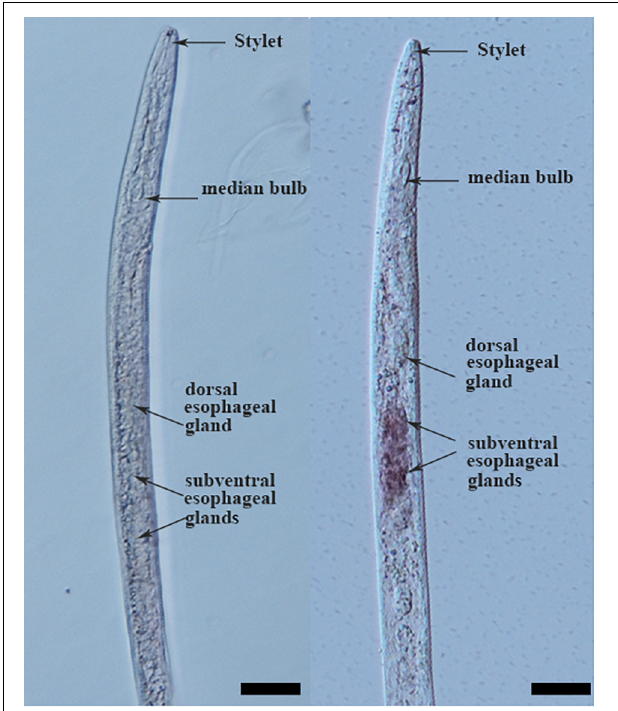
FIGURE 2 | Subventral gland localization of Mg-PEL1 in the pre-parasitic second stage juveniles of Meloidogyne graminicola . Fixed nematodes were hybridized with digoxigenin-labeled Mg-PEL1 sense cDNA probe (left) and antisense cDNA probe (right). Scale bars, 20 µ m.